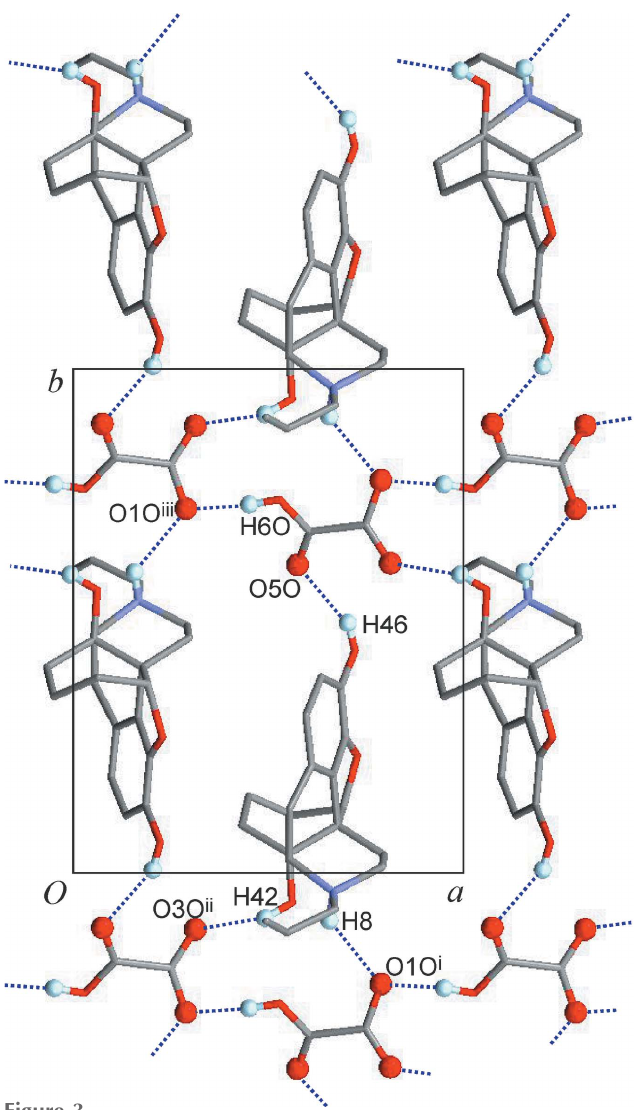
Figure 3 Hydrogen-bonded layer structure of (I), viewed along the c axis. H and O atoms directly engaged in hydrogen bonding are drawn as balls. All other H atoms and the polyether group are omitted for